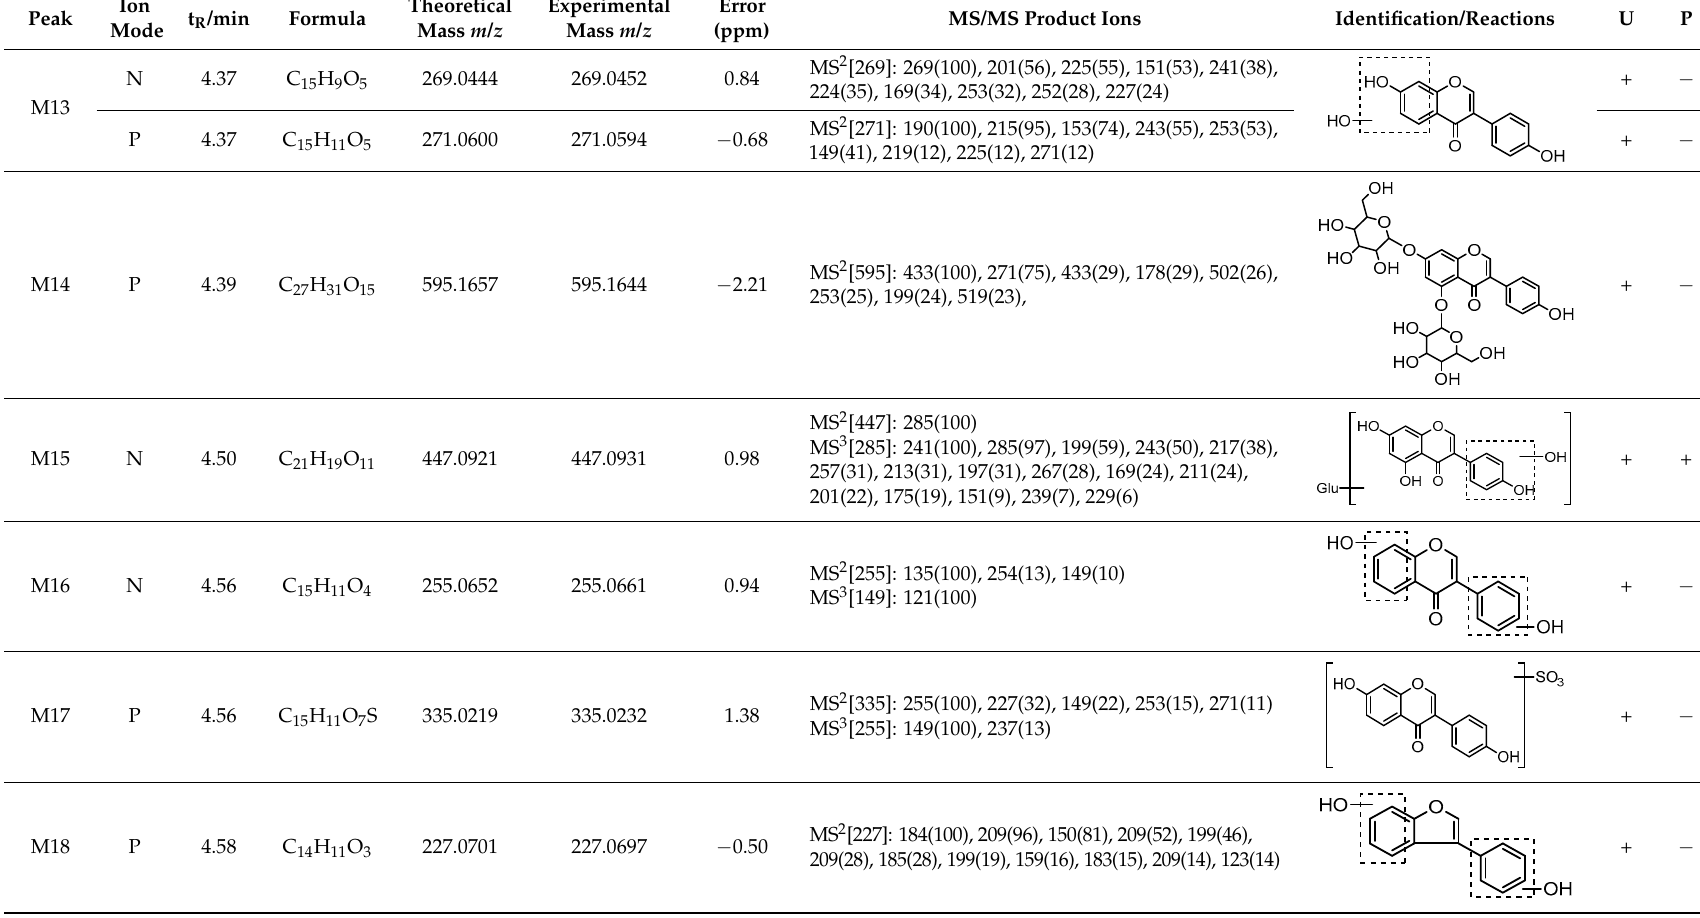
Table 1. Summary of daidzein metabolites in rat urine and plasma.